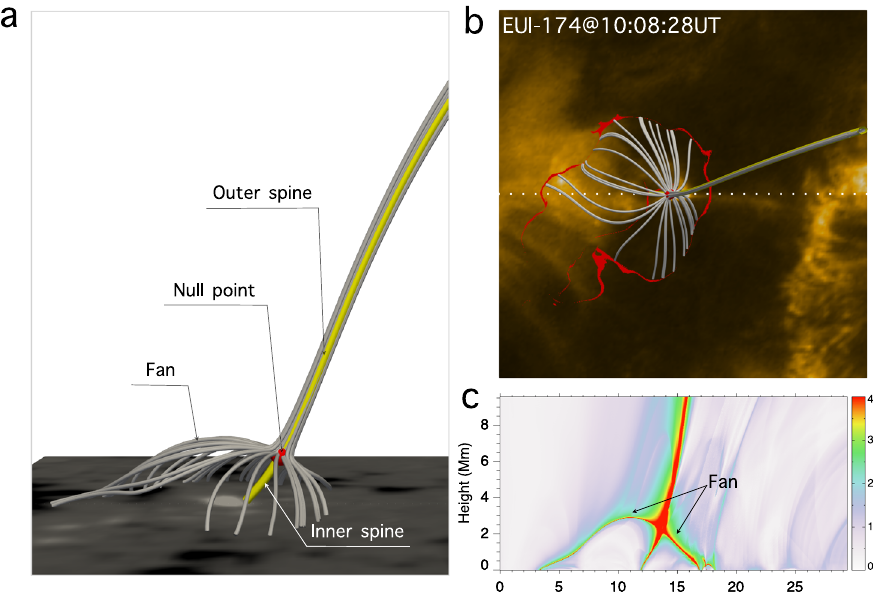
Fig. 3 | 3D potential con fi guration of the null-point and associated fan-spine. a 3D magnetic fi eld lines near the fan surface (grey) and the inner and outer spine lines (yellow) with a null-point (red) located at the crosspoint between the spine and fan surface. The bottom boundary shows the radial component of the HMI vectormagnetogramwithwhite(black)denotingpositive(negative)polarity. b Top